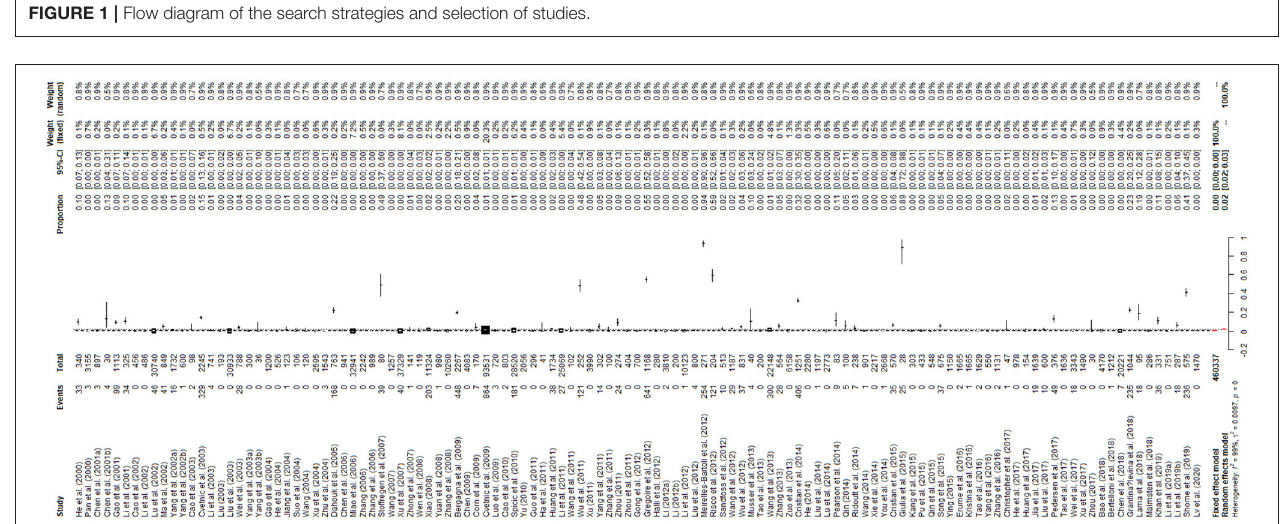
FIGURE 1 | Flow diagram of the search strategies and selection of studies.